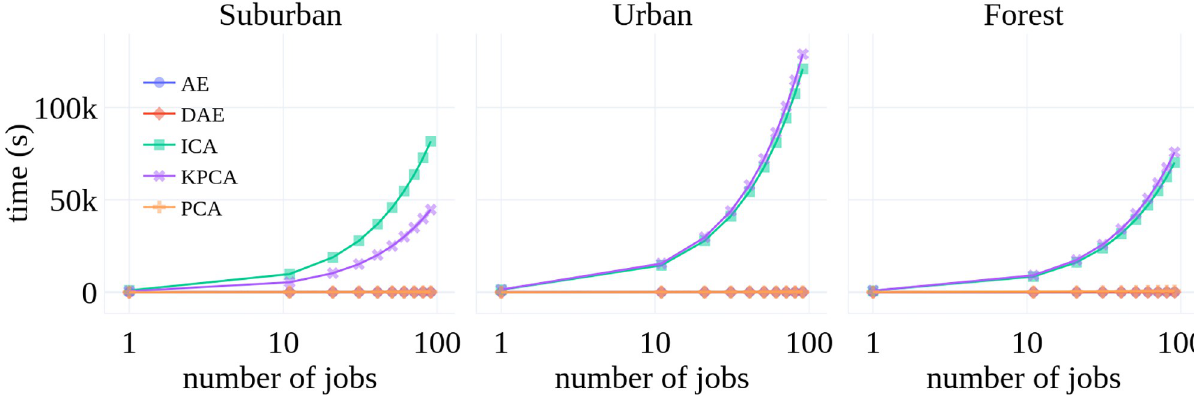
Fig 13. Execution times (in seconds) times the number of classification